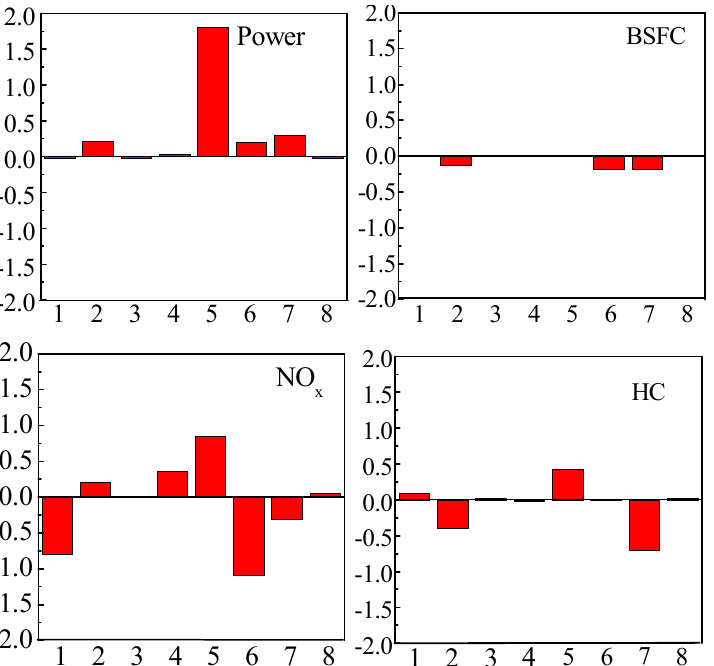
Figure 12. Comparisons of relative contribution on the engine characteristic in high speed (1000 rpm) and in lean operation zone (Equivalence ratio Φ = 0.25).